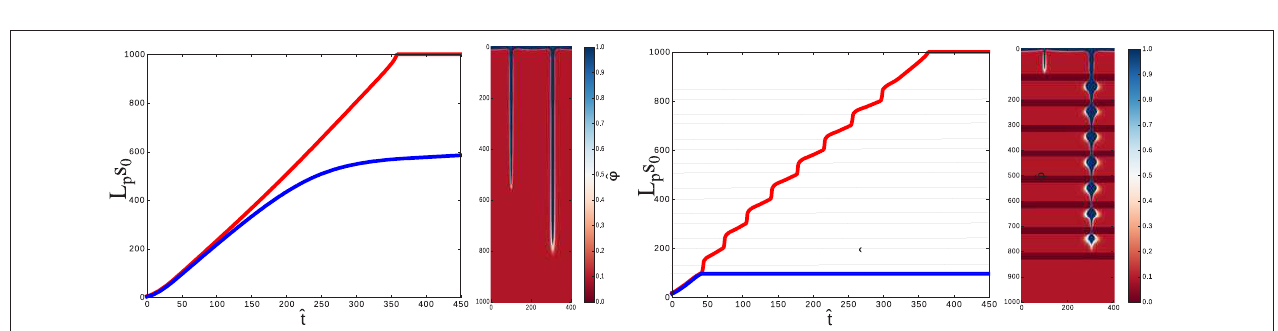
FIGURE 9 | Same as in Figure 7 but for a larger value of the initial noise.